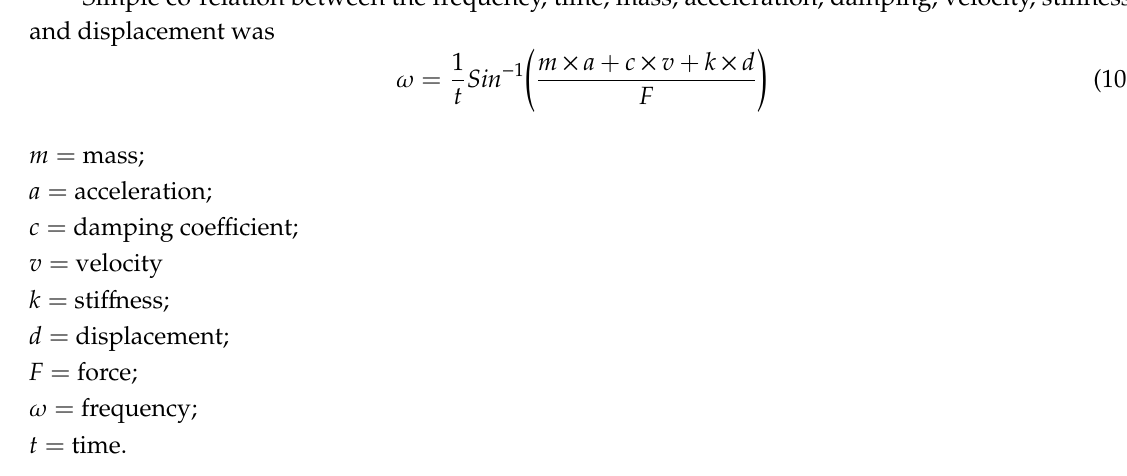
Figure 6. Vertical displacements at the points of interest.